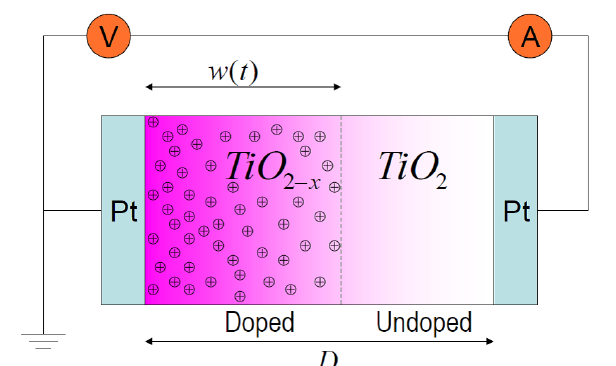
Fig. 4: Cross-section of the first HP TiO 2 -memristor consisting of a high conductive (doped) and a low conductive (undoped) part placed in between two platinum electrodes. The boundary between the two parts is dynamic and is moved back and forth by the passing charge carriers. The parameter w(t) is a mathematic variable that describes the position of this boundary [4]. Courtesy of C.